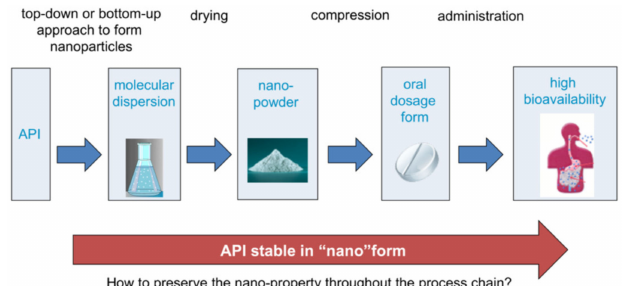
Figure 6. Exemplary process